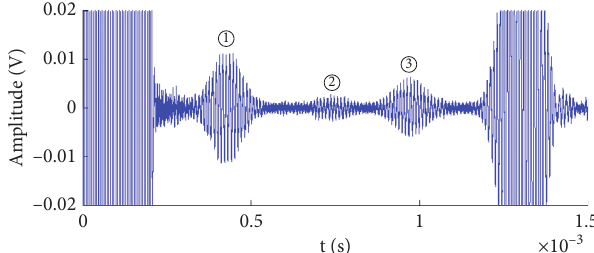
Figure 22: Temporal waveforms received from a specimen with three defects along the axial direction.